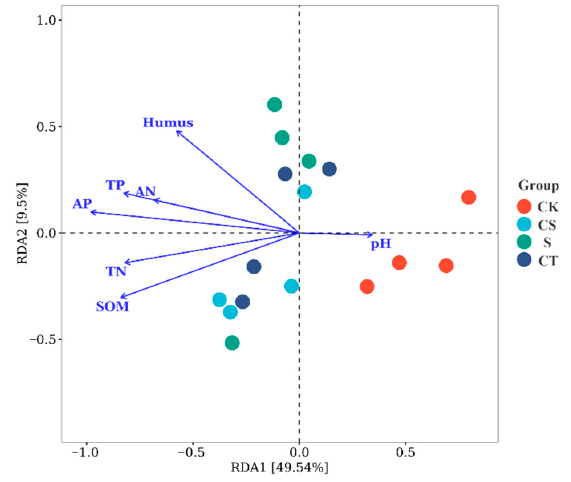
Figure 5. Ordination plots by RDA at the phylum level to explore the relationships between the phoD community and soil properties. Samples from different fertilization treatments were marked with different colors.